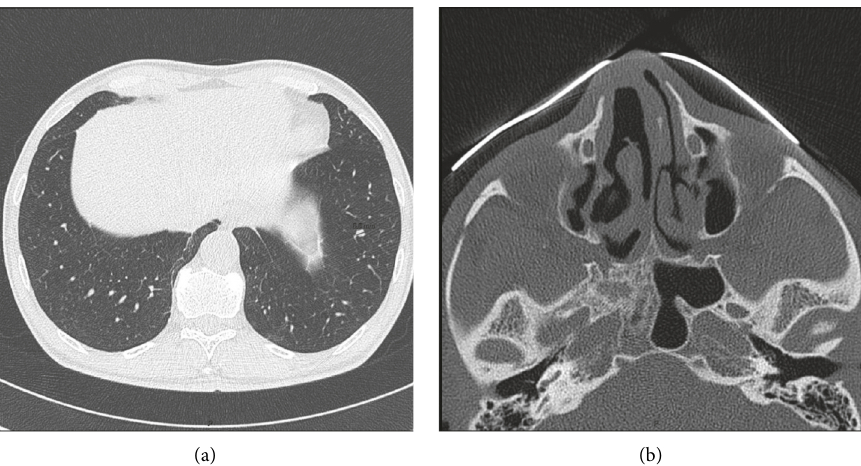
Figure 1: Computed tomography of lungs showing several micronodules (a) and that of sinus showing pansinusitis (b).